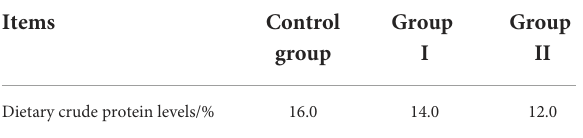
TABLE 1 Study design. TABLE 2 Composition and nutrient levels of experimental diets (air-dry